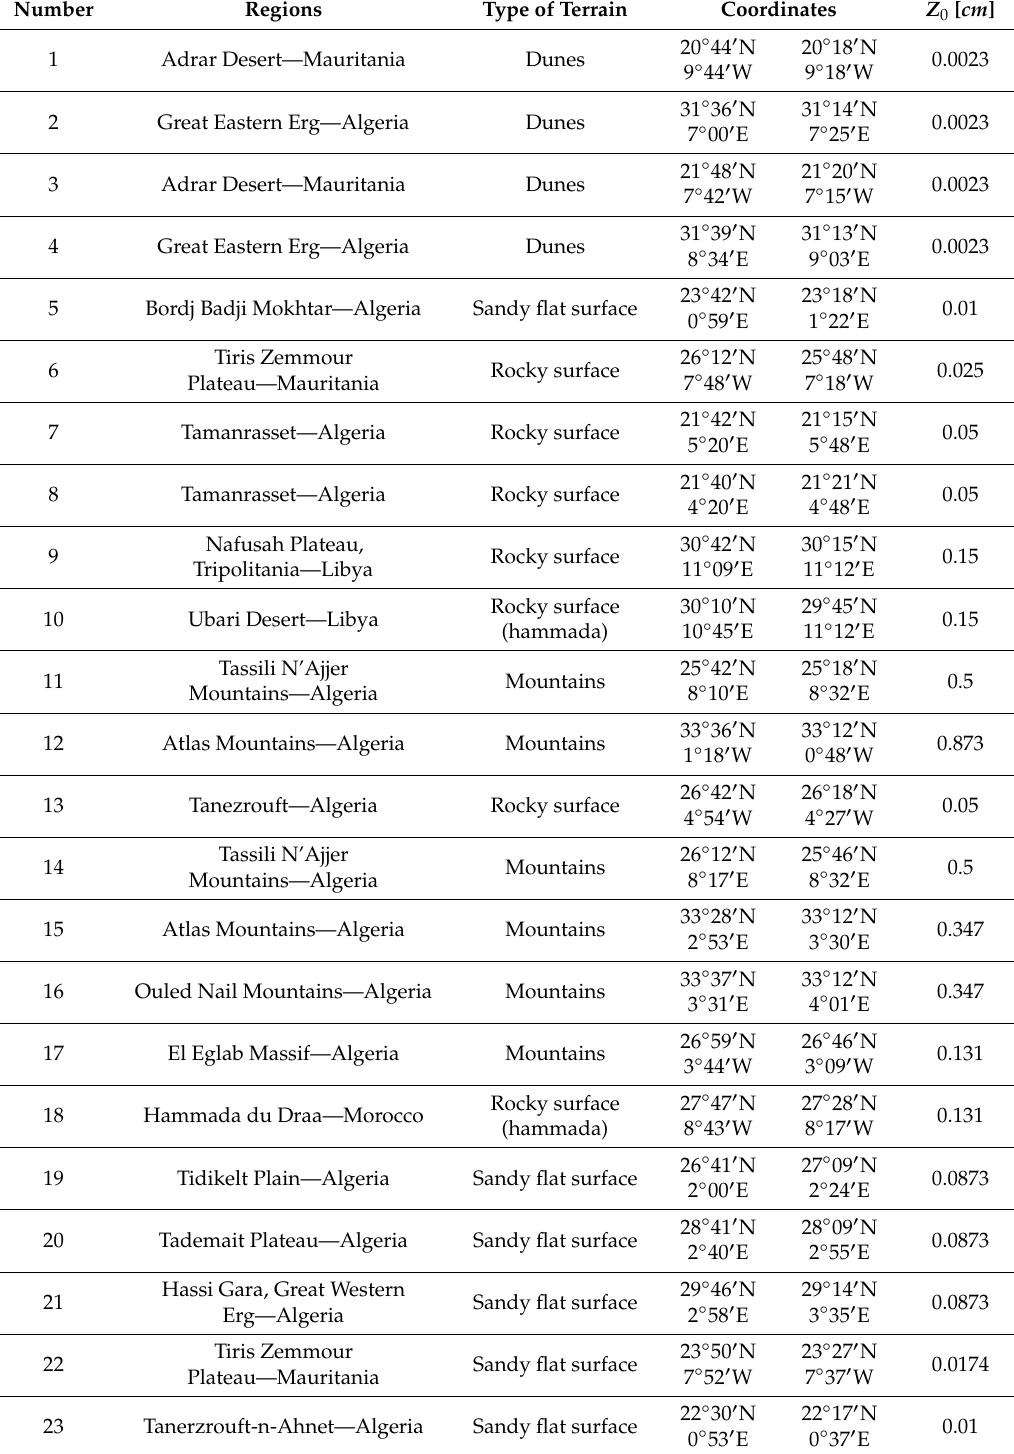
Table 1. Aerodynamic roughness ground measurements over the Sahara site